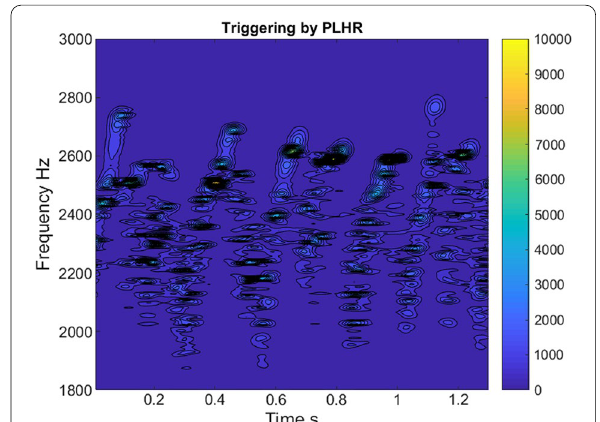
Fig. 5 Wave particle effects in PLHR radiation. The signal breaks up into rising elements with short risers at the top of the active